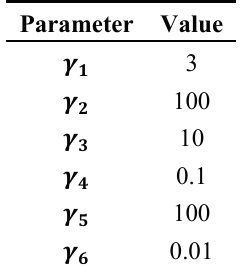
Table 2. Friction